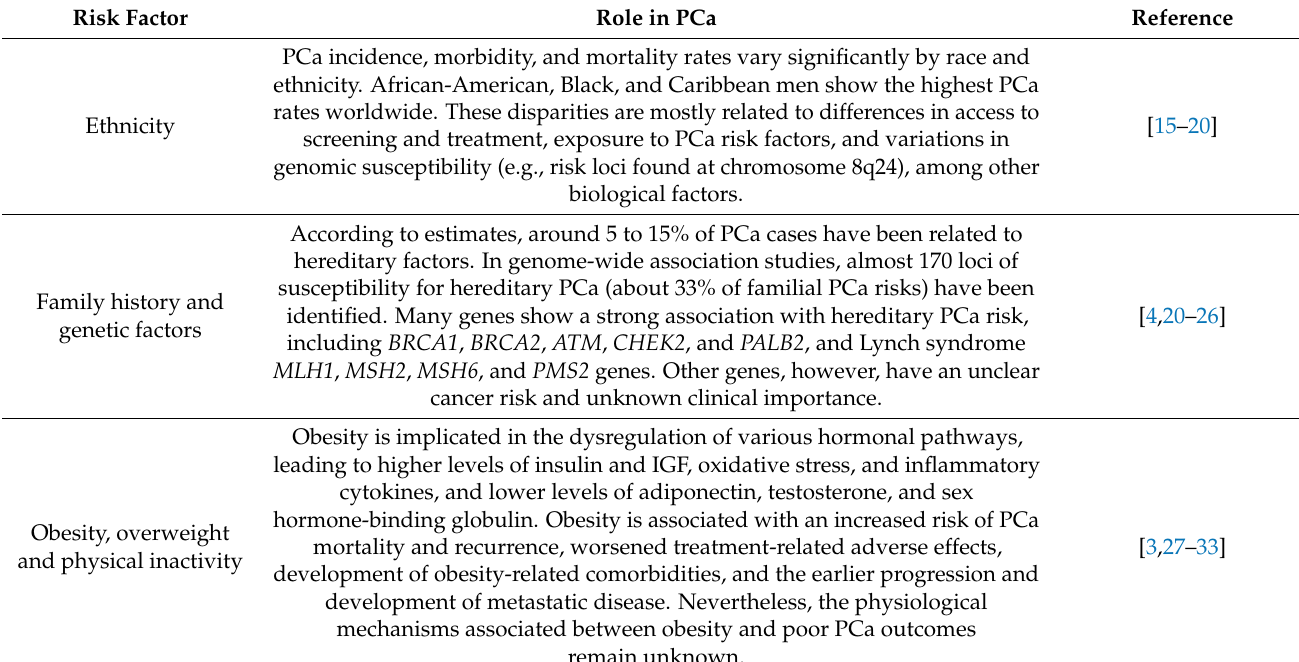
Table 1. Prostate cancer risk factors and their roles in the development of this tumor (articles from the last 5